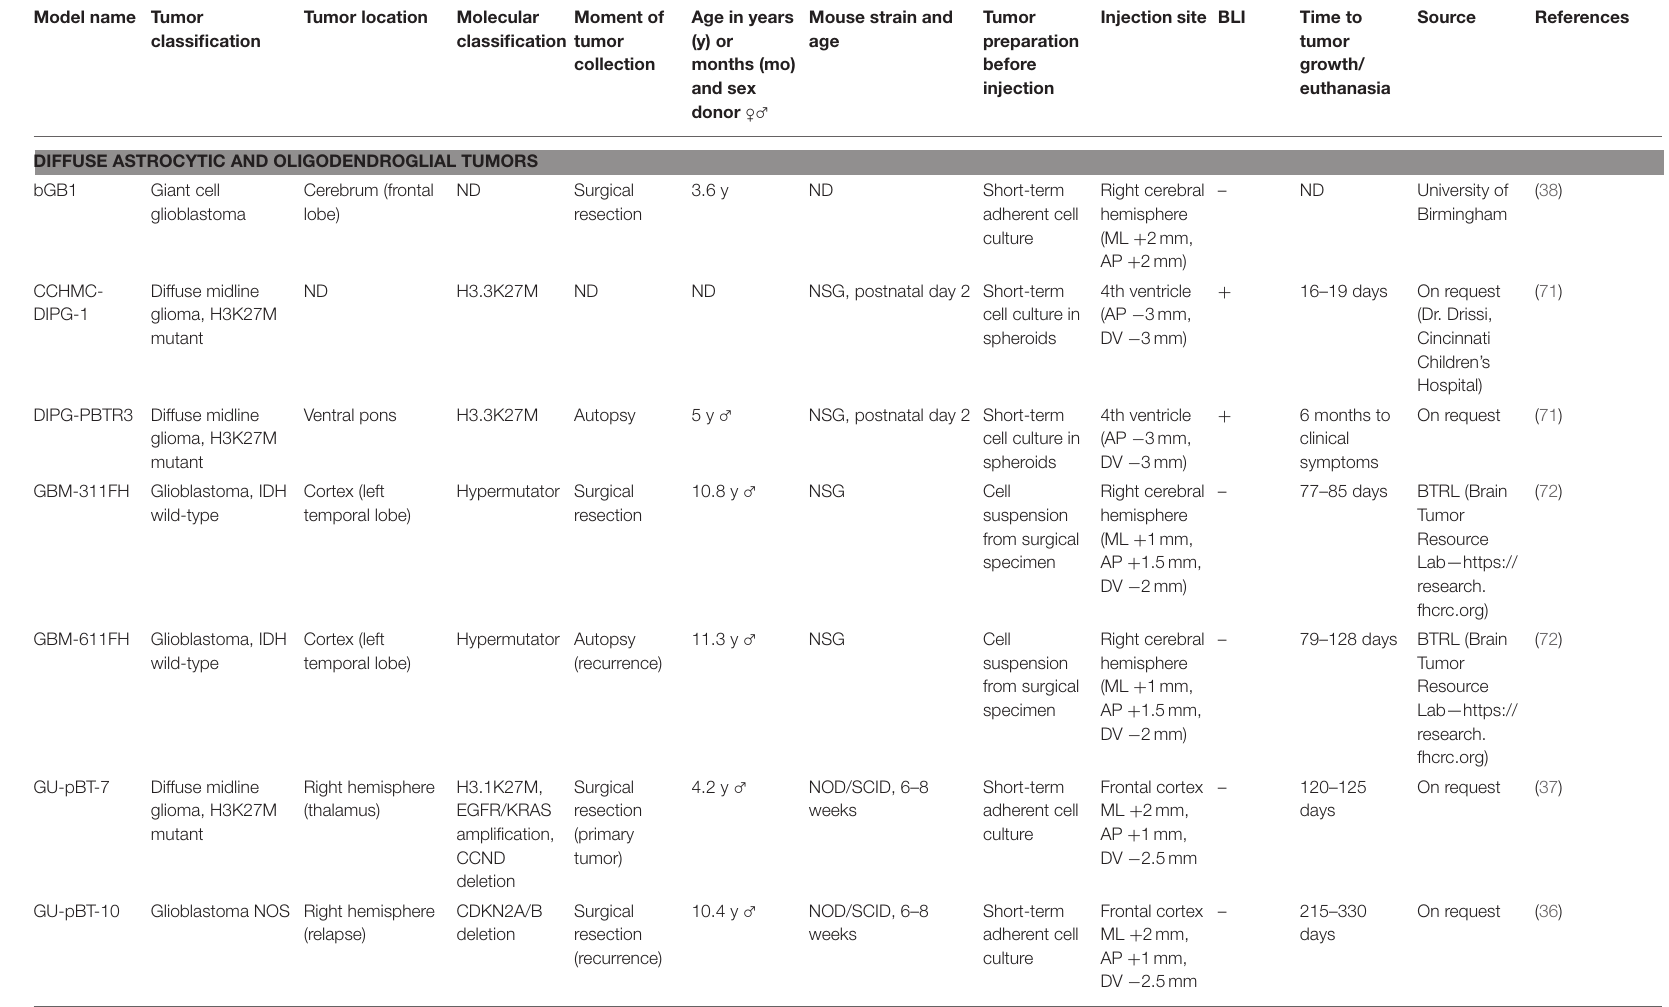
TABLE A1 | Overview of available orthotopic xenograft models per tumor entity, based on the 2016 WHO classification of tumors of the central nervous